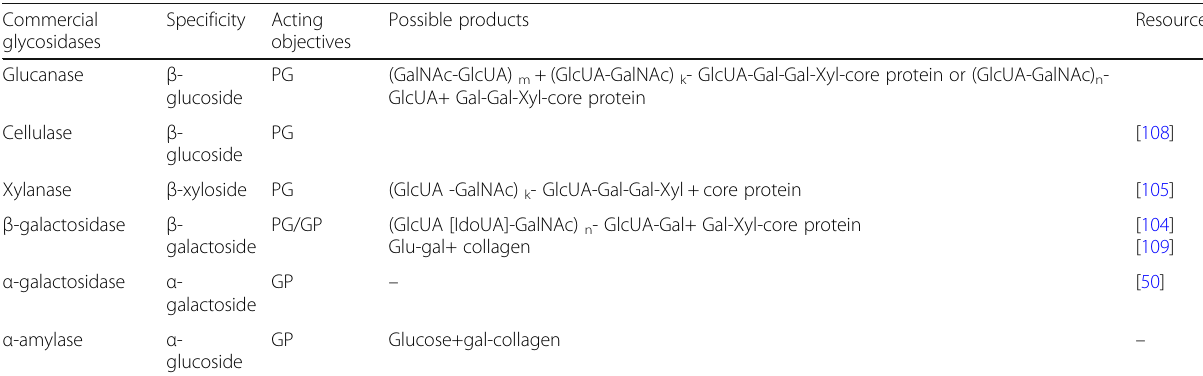
Table 2 The possible acting sites and products of some typical commercial glycosidases hydrolyzing glyco-protein conjugates in skin